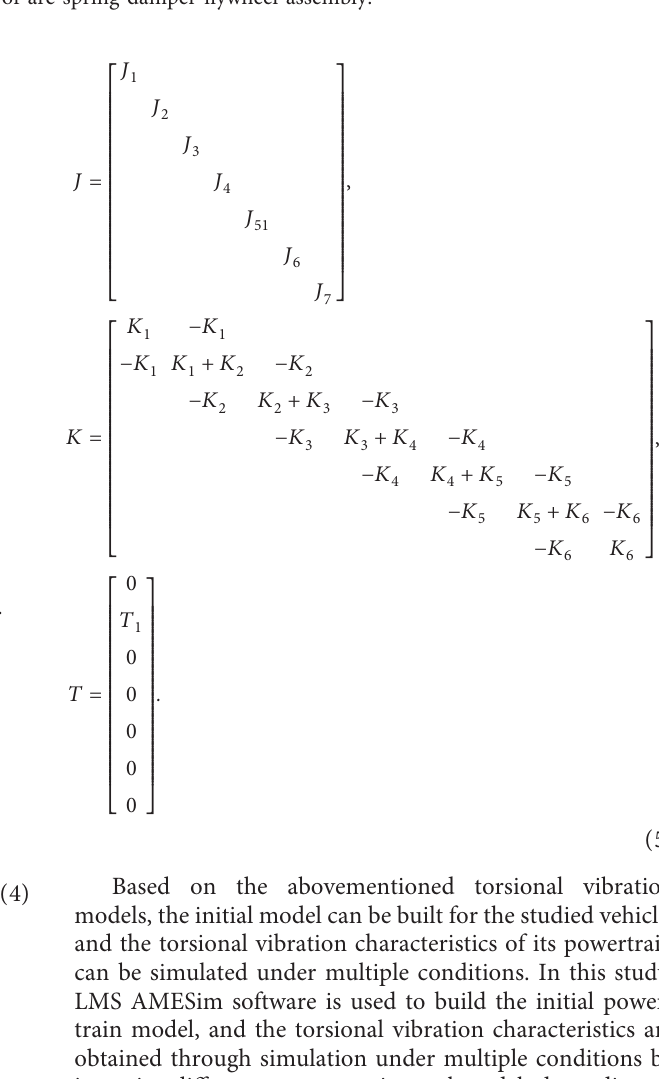
Figure 2: Structure diagram of arc spring damper flywheel assembly.